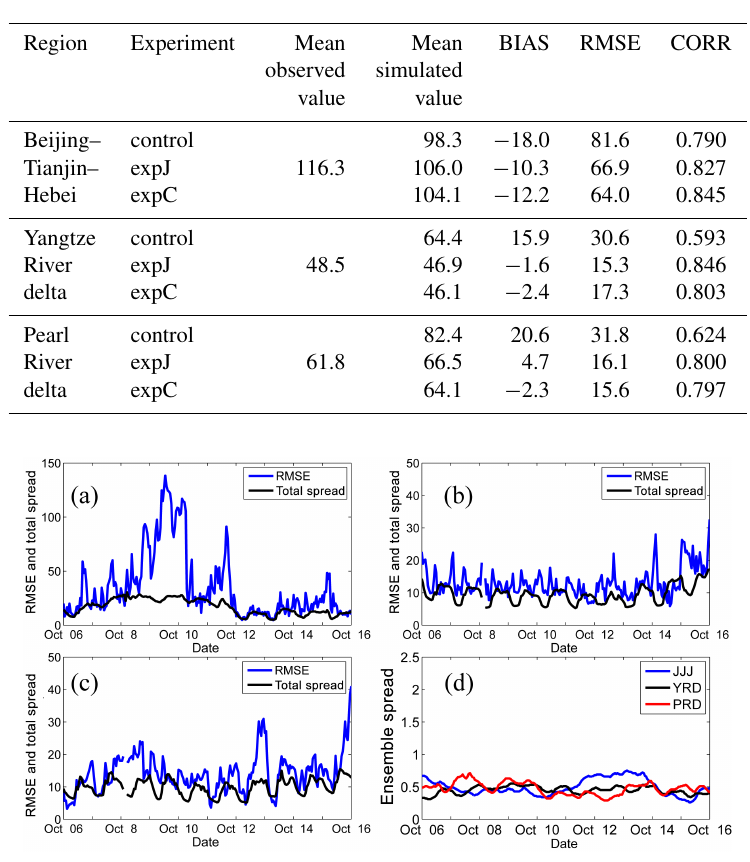
Table 1. Comparison of the surface PM 2 . 5 mass concentrations from the control and assimilation experiments to observations over all analysis times from 6 to 16 October 2014.